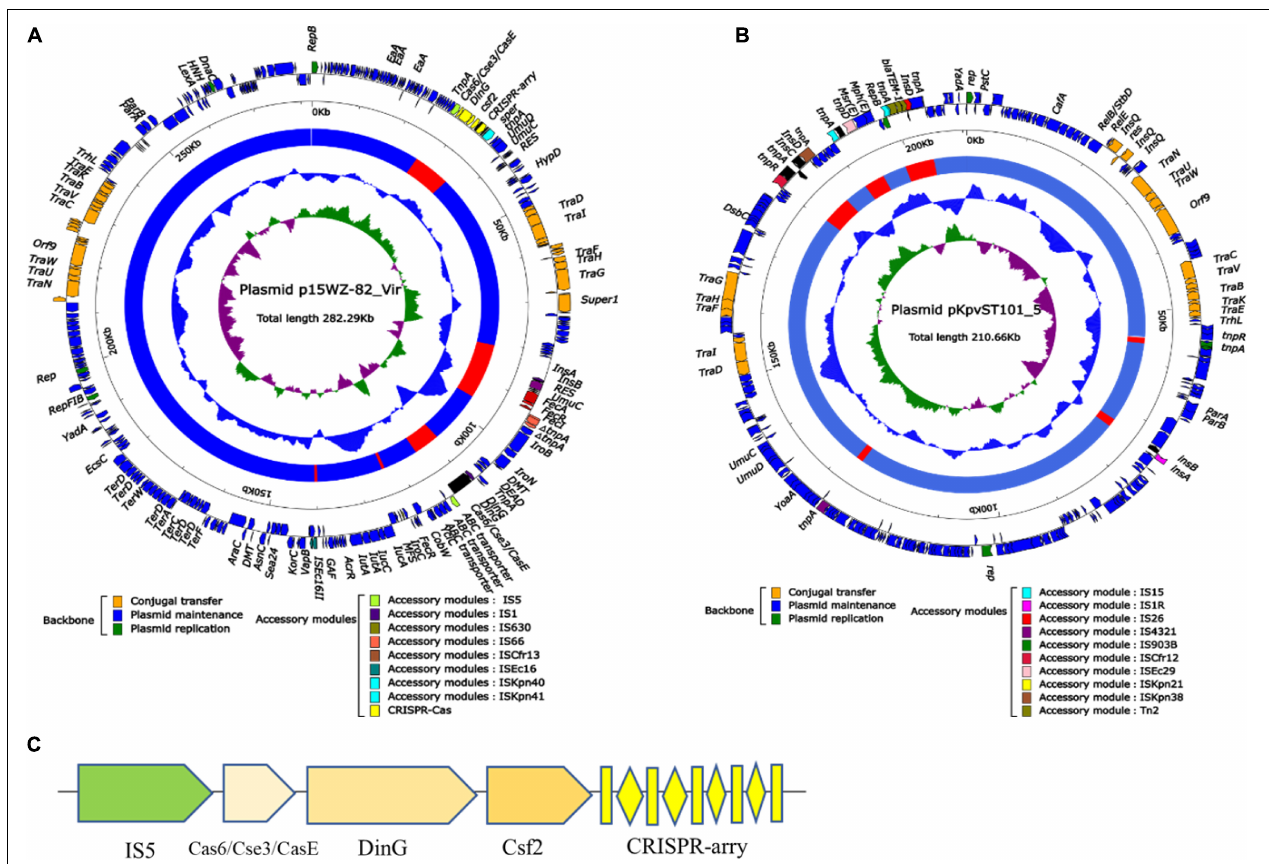
FIGURE 5 | (A) Schematic diagram of the Plasmid p15WZ-82_Vir. (B) Schematic diagram of the Plasmid pKpvST101_5. According to the function of the gene classification, use arrows to represent the gene, and color. (C) Local structure of plasmid CRISPR.